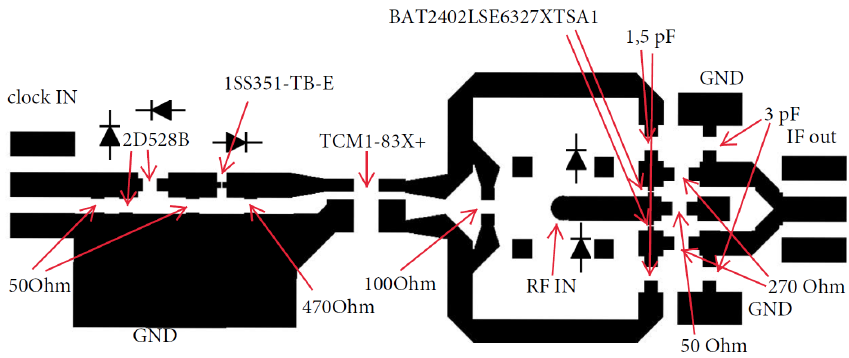
Figure 7. Simulated outline of sampler PCB, developed from the schematic in Figure 5.